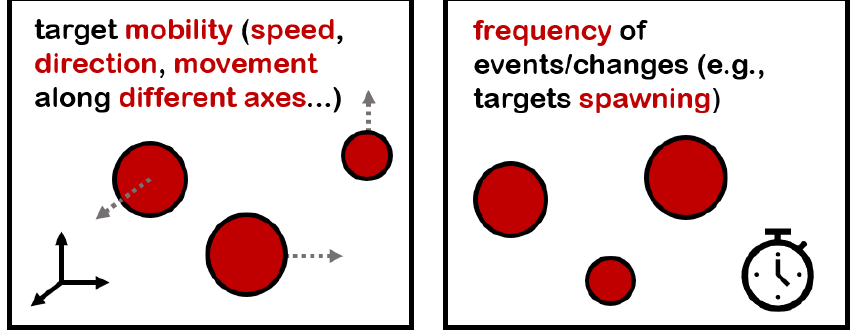
Figure 9. Temporally variable target-related parameters.